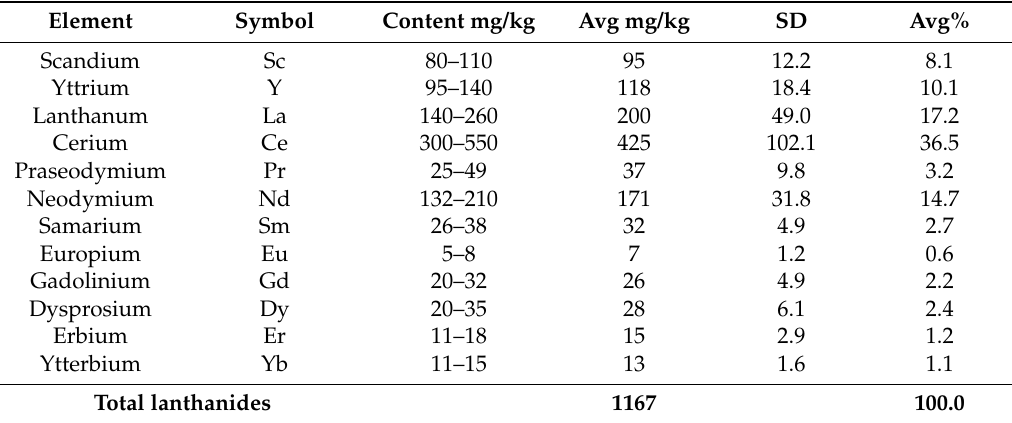
Table 1. Data on the quality and homogeneity of lanthanides in the red mud from Alm á sfüz í t˝o, Hungary.